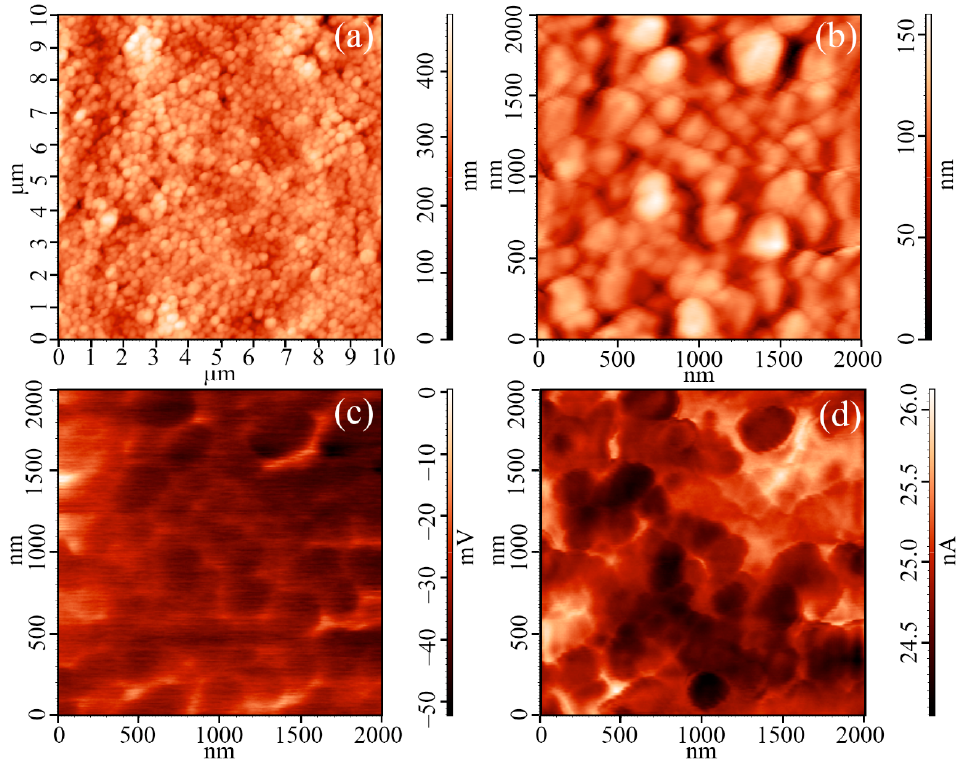
Figure 6. AFM results for the printed V 2 O 5 film: Topography ( a,b ), maps of potential surface distribution ( c ), and gradient in capacity of “probe tip-sample surface” capacitor distribution ( d ).